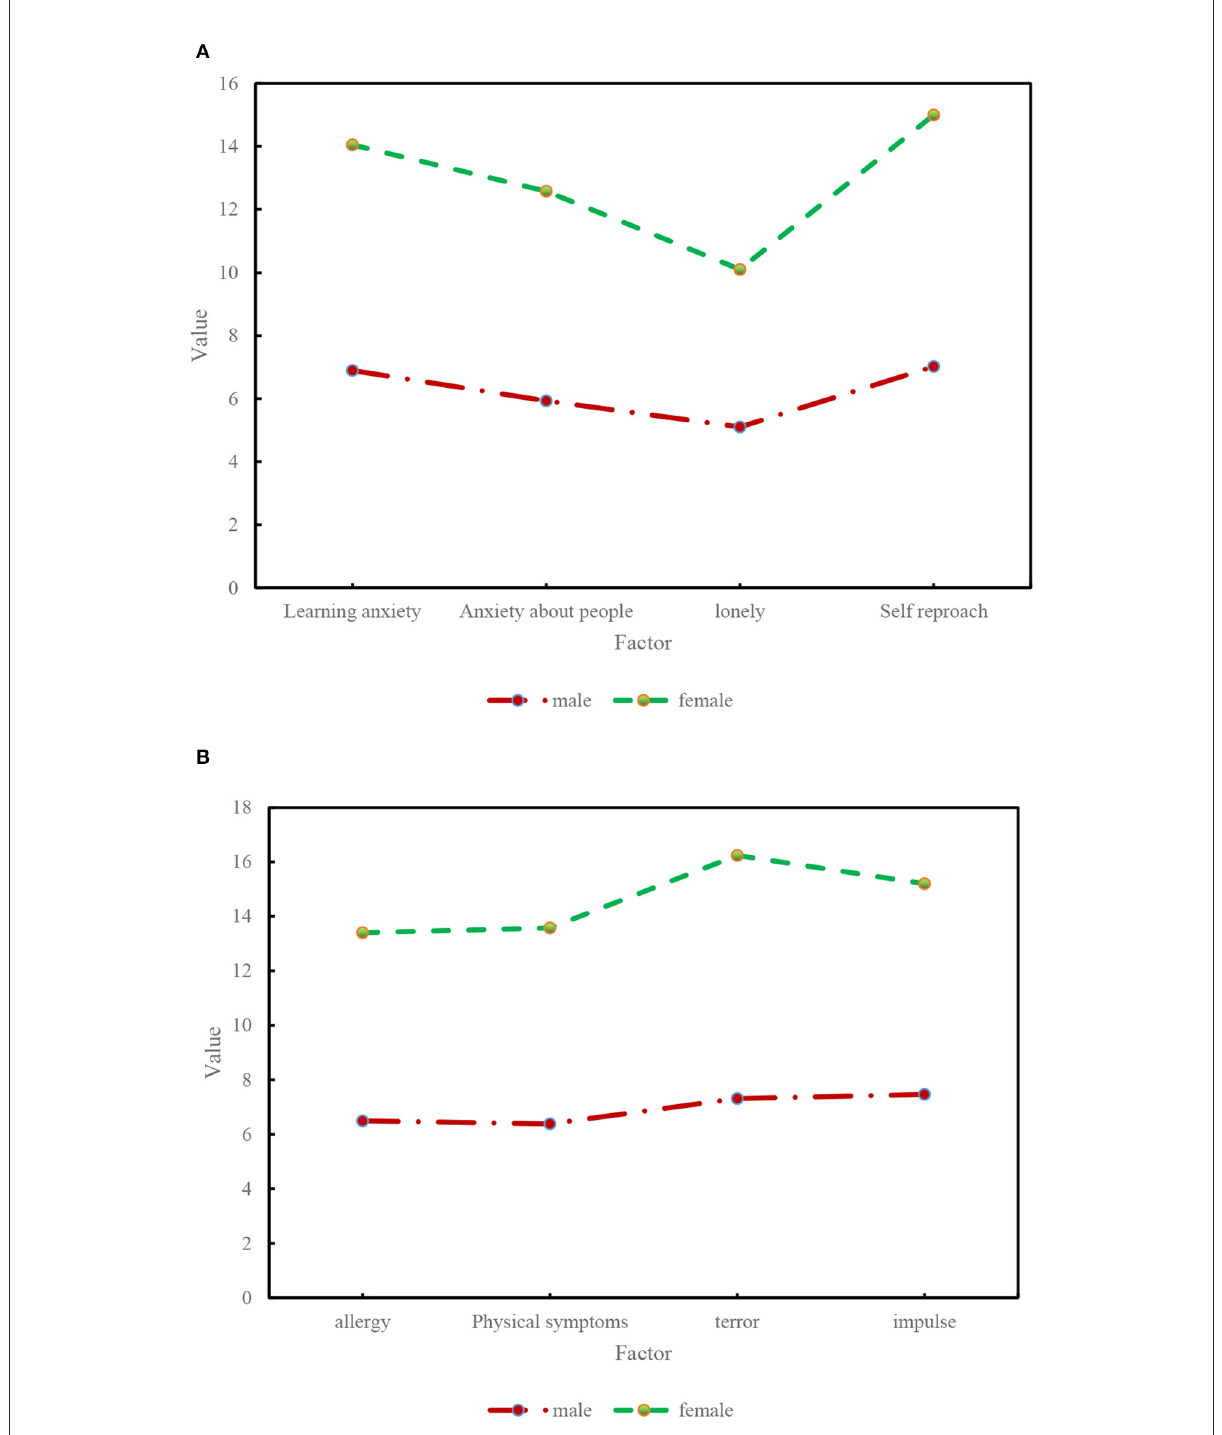
FIGURE12 Differences in the mental health status of able-bodied students by